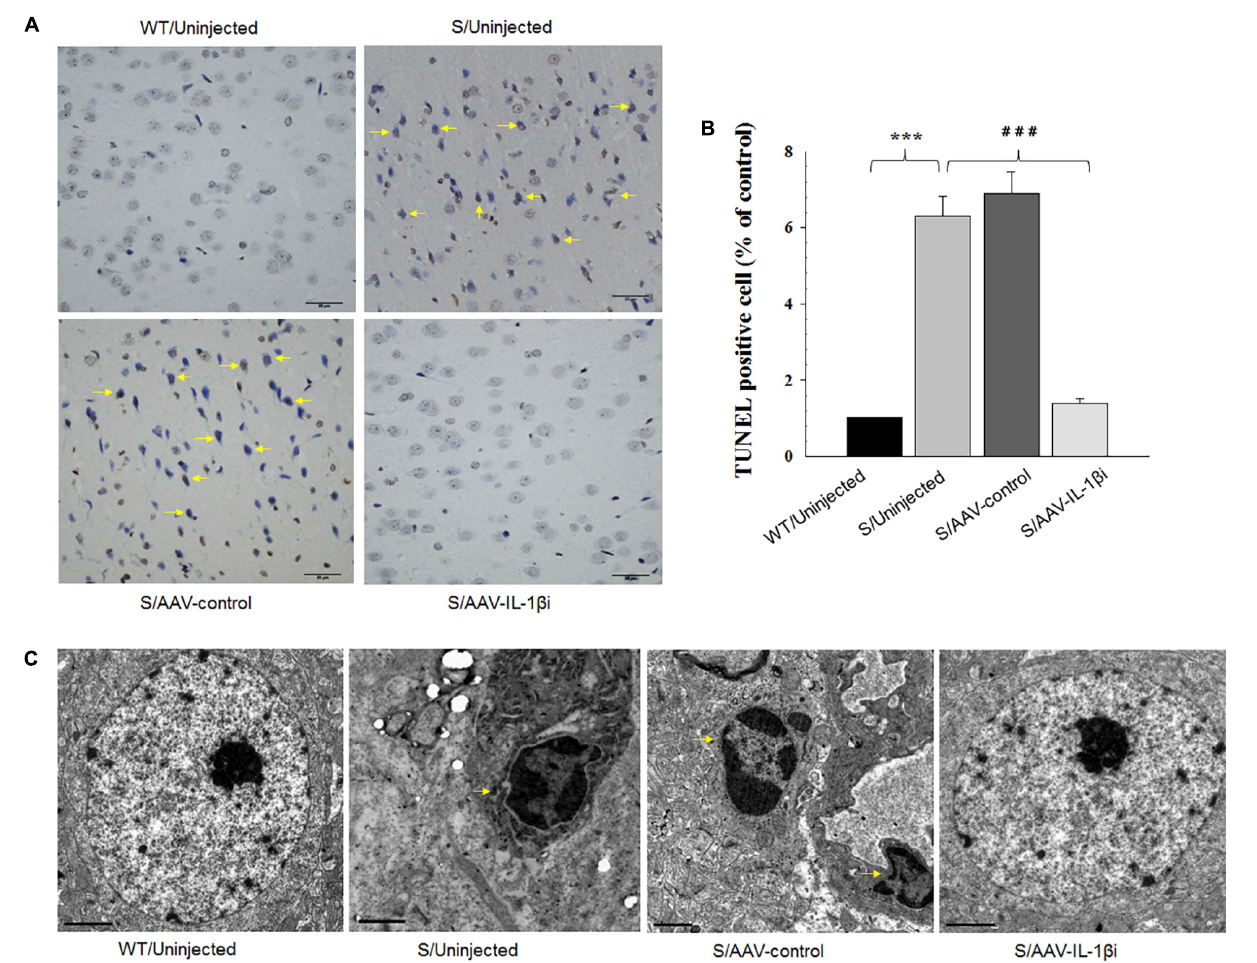
FIGURE 8 | Knocking-down of IL-1 β in the vmPFC decreased neuronal apoptosis within the vmPFC of stressed rats. (A) TUNEL positive apoptotic cells (indicated by the arrows) in vmPFC regions infected with AAV-IL-1 β RNAi construct. (B) Histograms showing the decreased TUNEL positive cells caused by AAV-IL-1 β RNAi construct infusion. (C) nuclear chromatin abnormalities in vmPFC neurons infected with the AAV-IL-1 β RNAi construct. Arrows indicate nuclear chromatin aggregation, condensation and margination. N = 6/group. ∗ P < 0.05, ∗∗ P < 0.01, ∗∗∗ P < 0.001 Stressed rats vs. WT rats. # P < 0.05, ## P < 0.01, ### P < 0.001 S+AAV-IL-1 β RNAi vs. Stressed